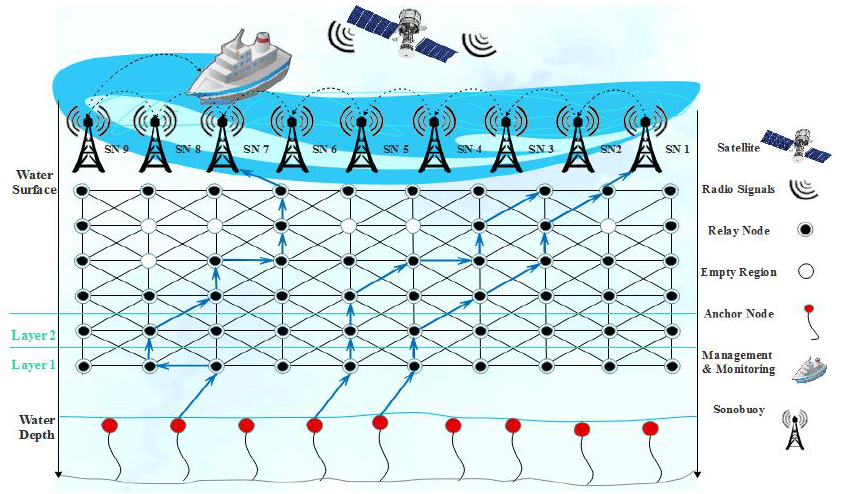
Figure 2. Proposed model of Tri-Angular Nearest Vector-Based Energy Efficient Routing (TAN-VEER).